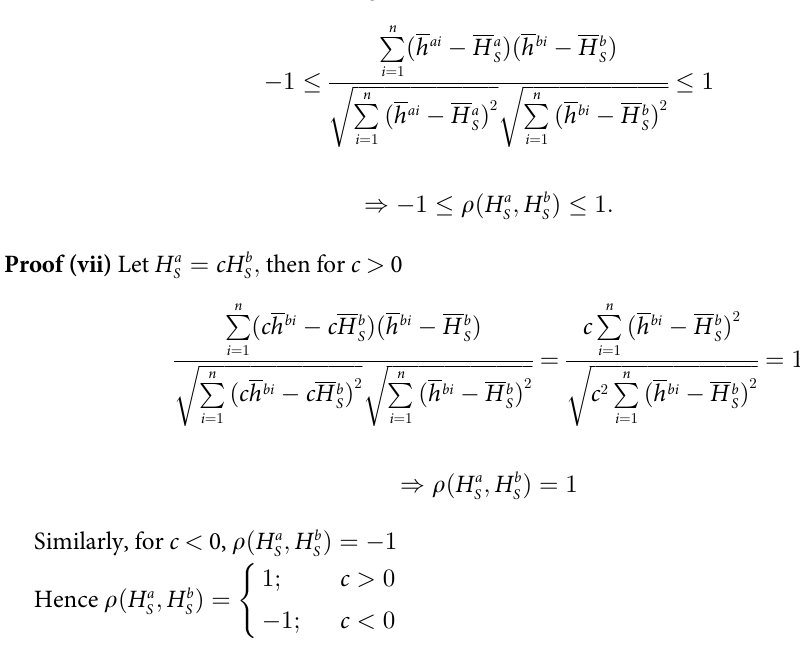
ffiffiffiffiffiffiffiffiffiffiffiffiffiffiffiffiffiffiffiffiffiffiffiffiffiffiffiffi P n